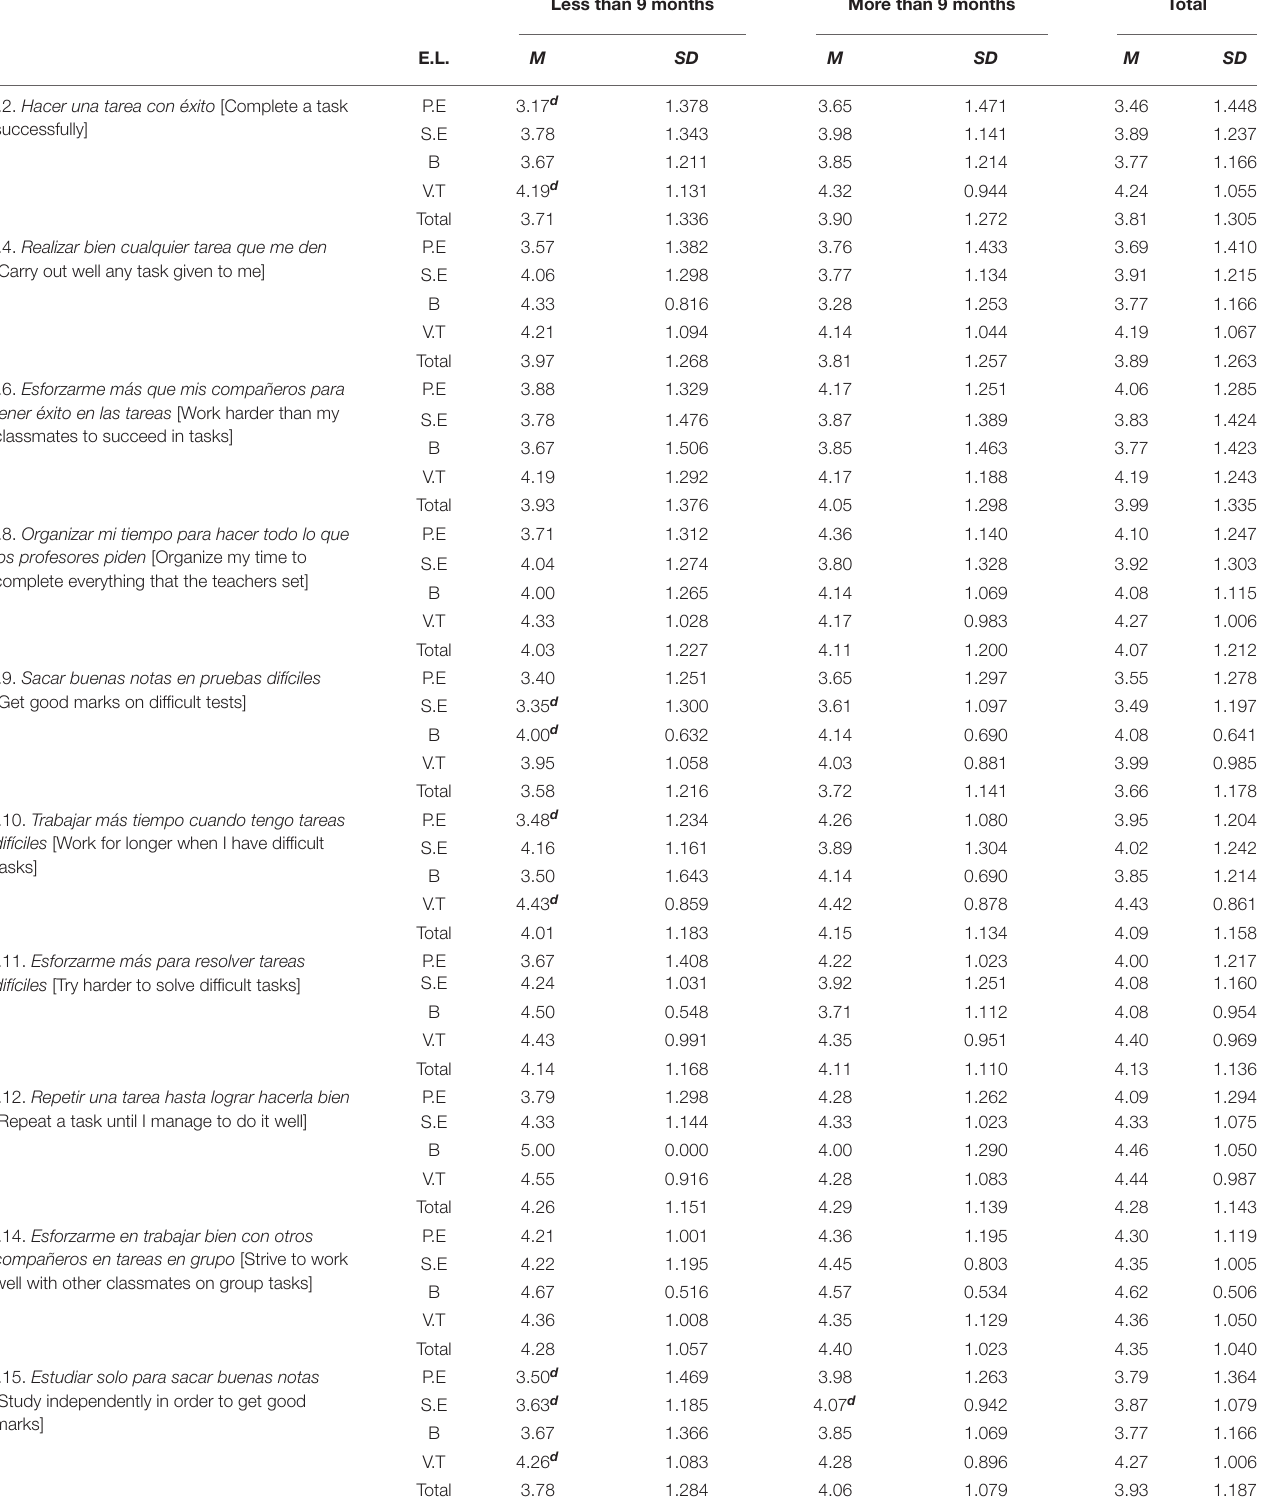
TABLE 1 | Means (M) and standard deviations (SD) for self-efficacy as a function of educational level (E.L) and length of